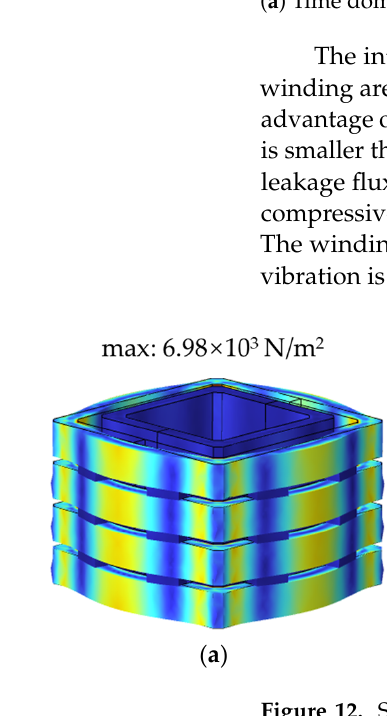
( b ) Figure 13. Stress distribution under middle-winding short circuit ( a ) Interleaved winding; ( b ) Con- tinuous winding. ( a ) ( b ) Figure 14. Stress distribution under end-winding short circuit ( a ) Interleaved winding; ( b ) Contin- uous winding. 4.3. Acoustic Field Distribution The calculated result of the stress field is taken as the excitation of the sound field, and the sound pressure level distributions are shown in Figures 15–17. It can be seen from the sound pressure level distribution diagram in the longitudinal section of HFT that the normal working conditions and fault conditions of the two windings show the same law, and the maximum sound pressure level appears in the HFT body and gradually decreases into the air. Meanwhile, the sound pressure level distribution of interleaved winding is slightly smaller than that of continuous winding, meaning that the distribution of sound pressure level before and after short circuit is completely different. The sound pressure level becomes more widely distributed under the influence of the inter-turn short circuit. For the HFT with interleaved winding, the maximum sound pressure level on the trans- former increases from 93.5 dB to 112 dB and 122 dB respectively, which depends on the vibration intensity on the transformer core and windings. Similarly, the HFT with contin- uous winding also has the distribution patterns mentioned above.